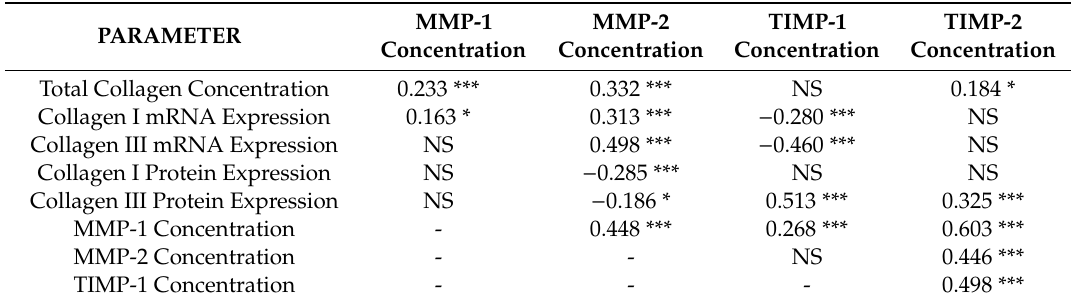
TIMP-1 Concentration -